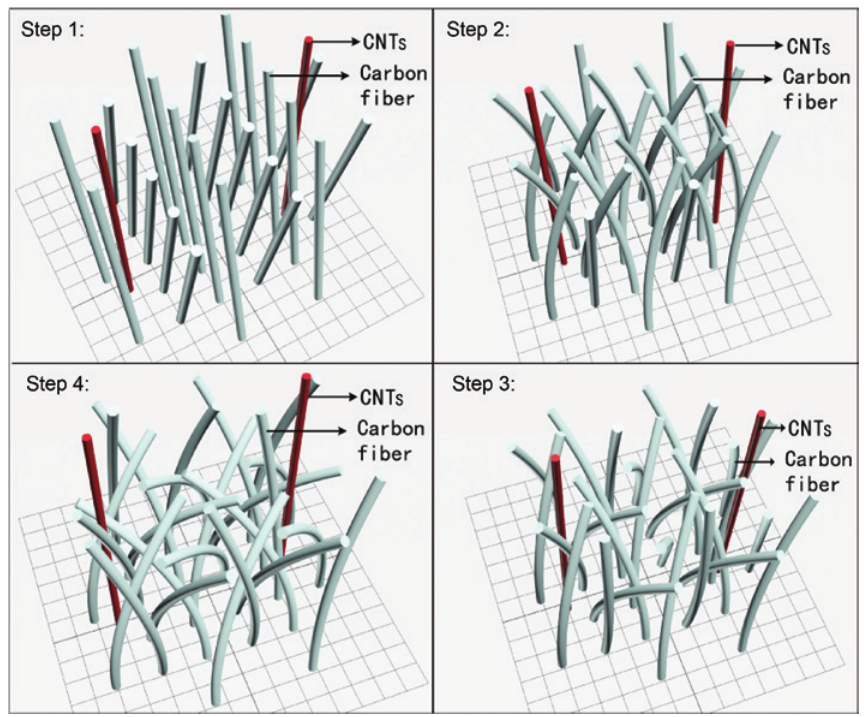
Figure 3: Yarn arrangement and movement rules of four steps braiding in 3-D five directions.